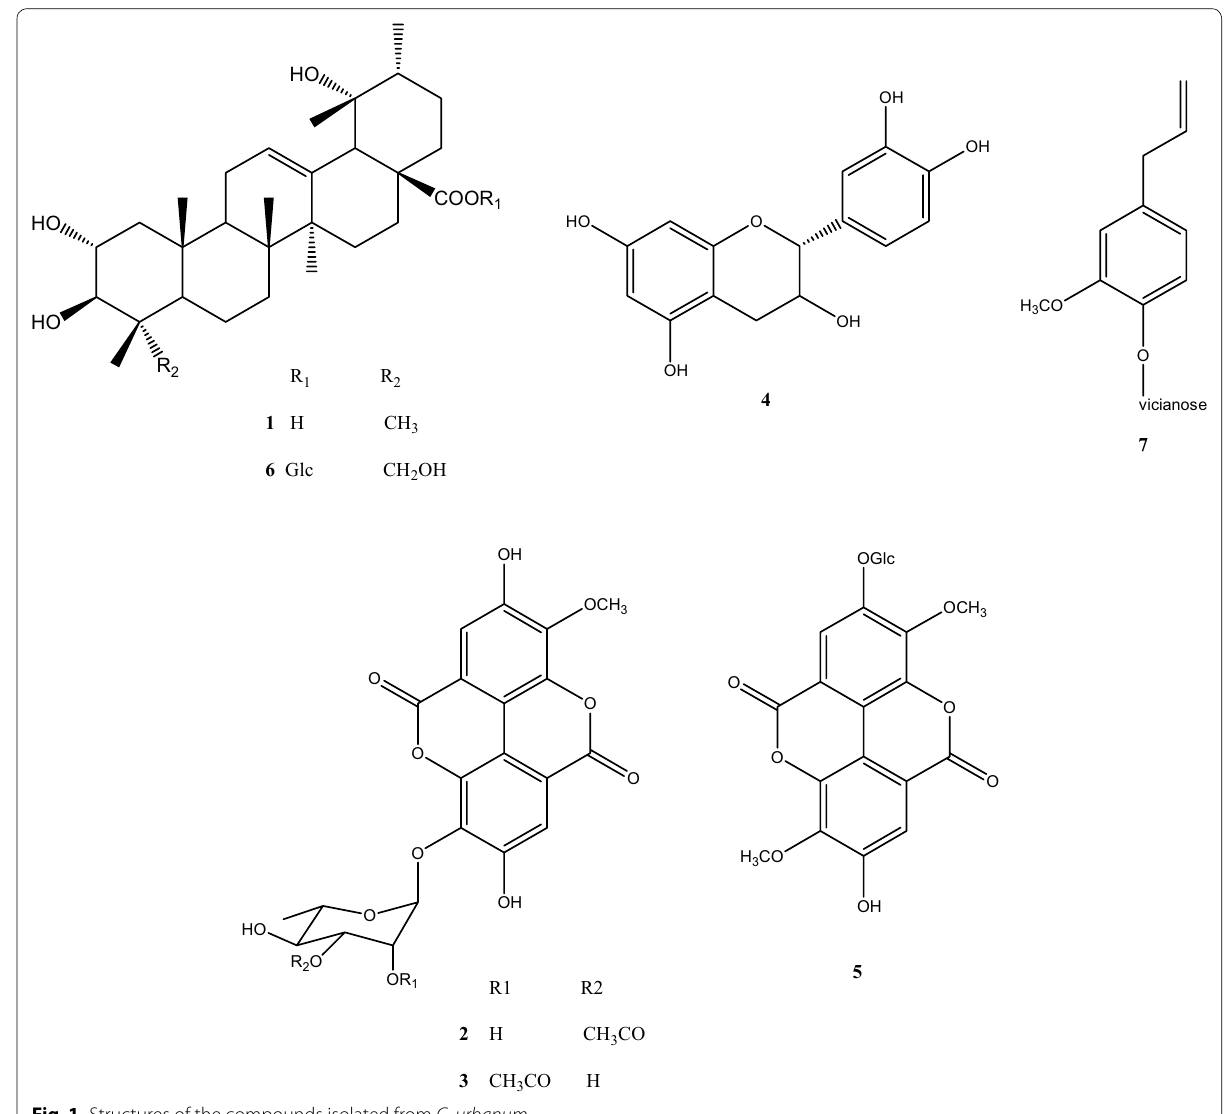
Fig. 1 Structures of the compounds isolated from G.